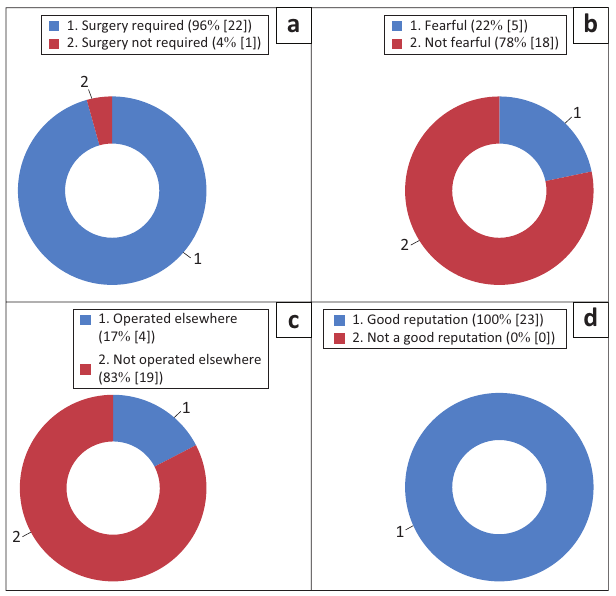
FIGURE 5: Percentage (and number) of non-attending patients who believed whether each factor contributed to their non-attendance: (a) belief that surgery was not necessary, n = 23 ; (b) fear of surgery, n = 23; (c) undertaking surgery elsewhere, n = 23; and (d) Good Shepherd Hospital Eye Clinic reputation, n =